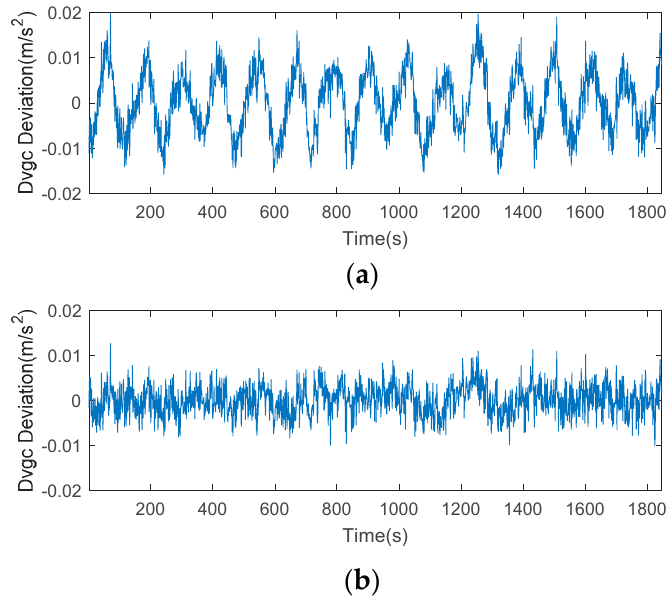
Figure 16. ( a ) CMCD (Time averaging, 100 epochs) in the time domain comparison before the adaptive frequency domain filter, C06, ( b ) CMCD (Time averaging, 100 epochs) in the time domain comparison after the adaptive frequency domain filter,